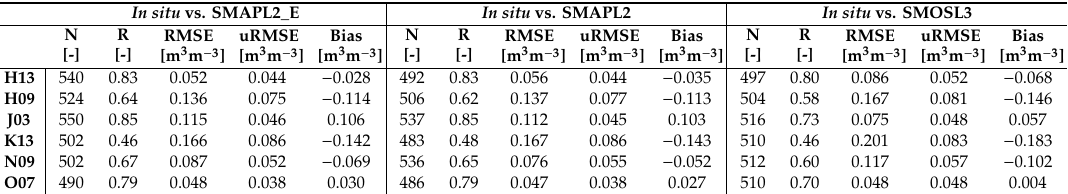
Table 3. Statistics obtained from the comparison of in situ SSM against the concurrent low-resolution (radiometer-only) pixels SSM time series: of SMAPL2_E (left), SMAPL2 (center) and SMOSL3 (right), from April 2015 to December 2017. The in situ stations used (and their respective land use) are: H13 (fallow), H9 (forest-pasture), J3 (vineyard), K13 (irrigated), N9 (rainfed) and O7 (rainfed / fallow). In situ vs. SMAPL2_E In situ vs. SMAPL2 In situ vs. SMOSL3 N H13 540 0.83